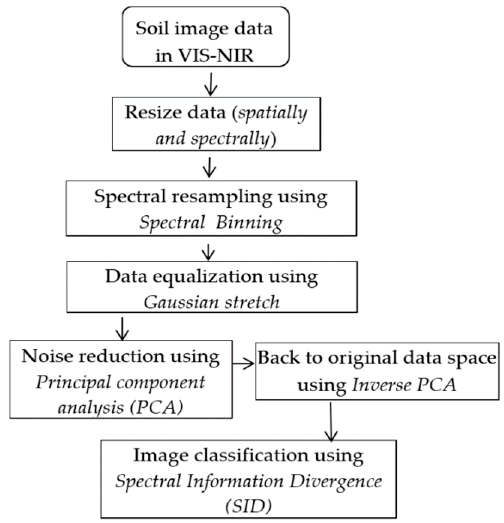
Figure 3. Flowchart of the image processing steps followed for each soil image before Spectral Information Divergence image classification was performed.